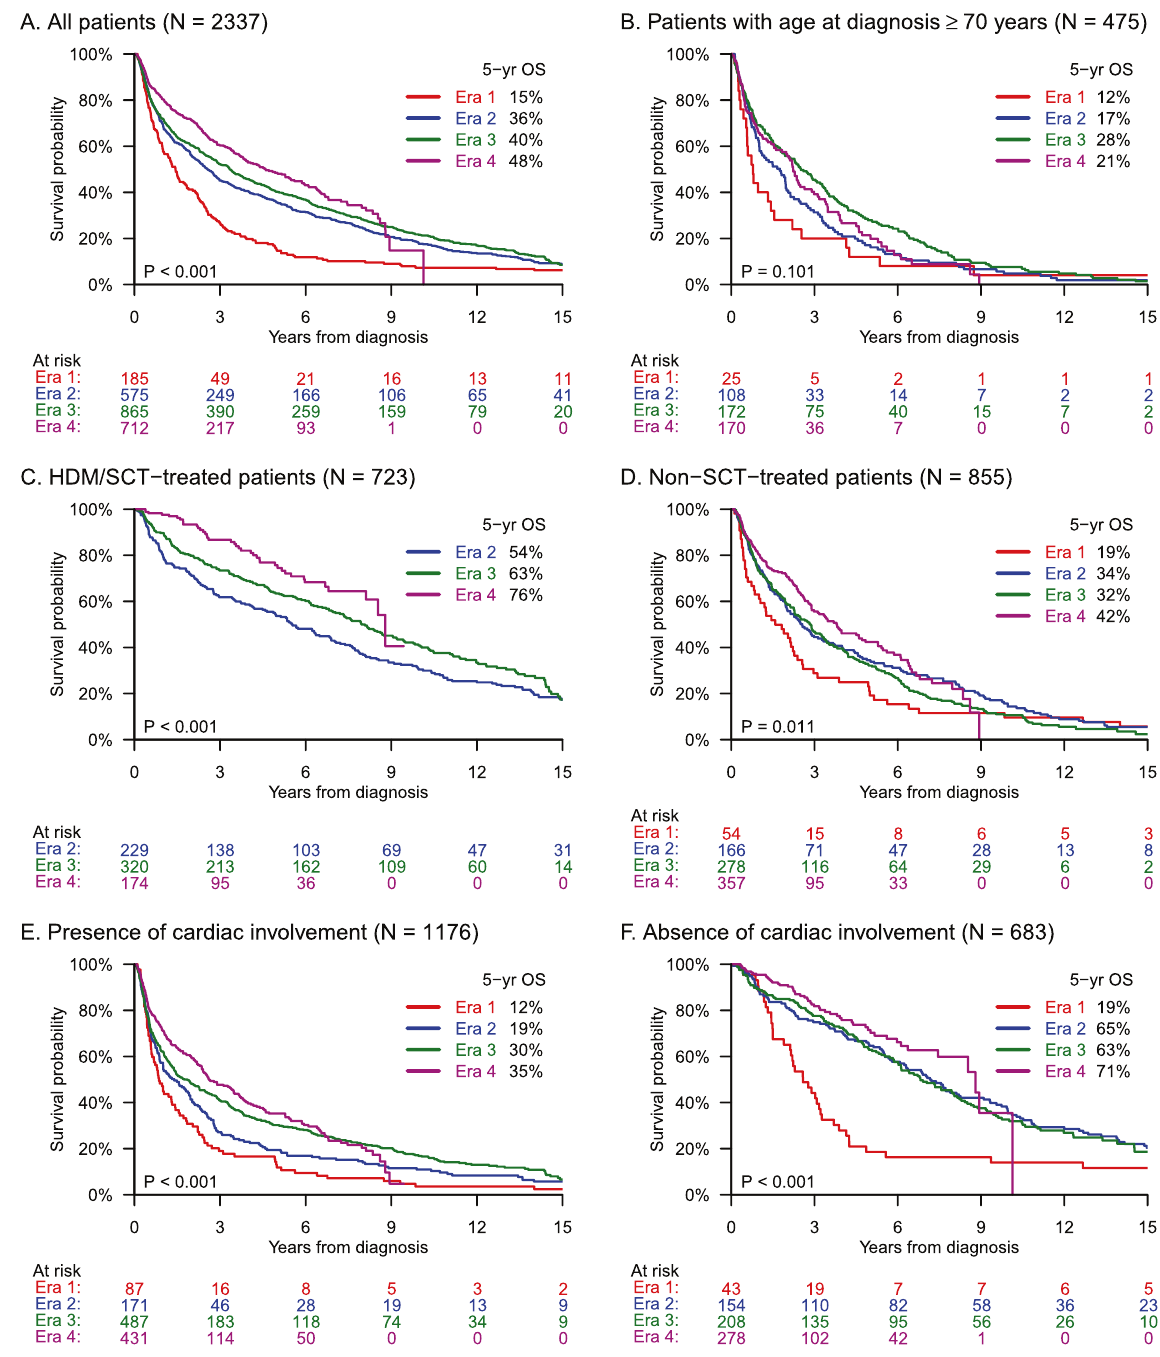
Fig. 1 Trends in overall survival over a 40-year period among patients with AL amyloidosis. Kaplan – Meier survival curves by era of diagnosis for the entire study population ( A ) and patient subgroups ( B – F